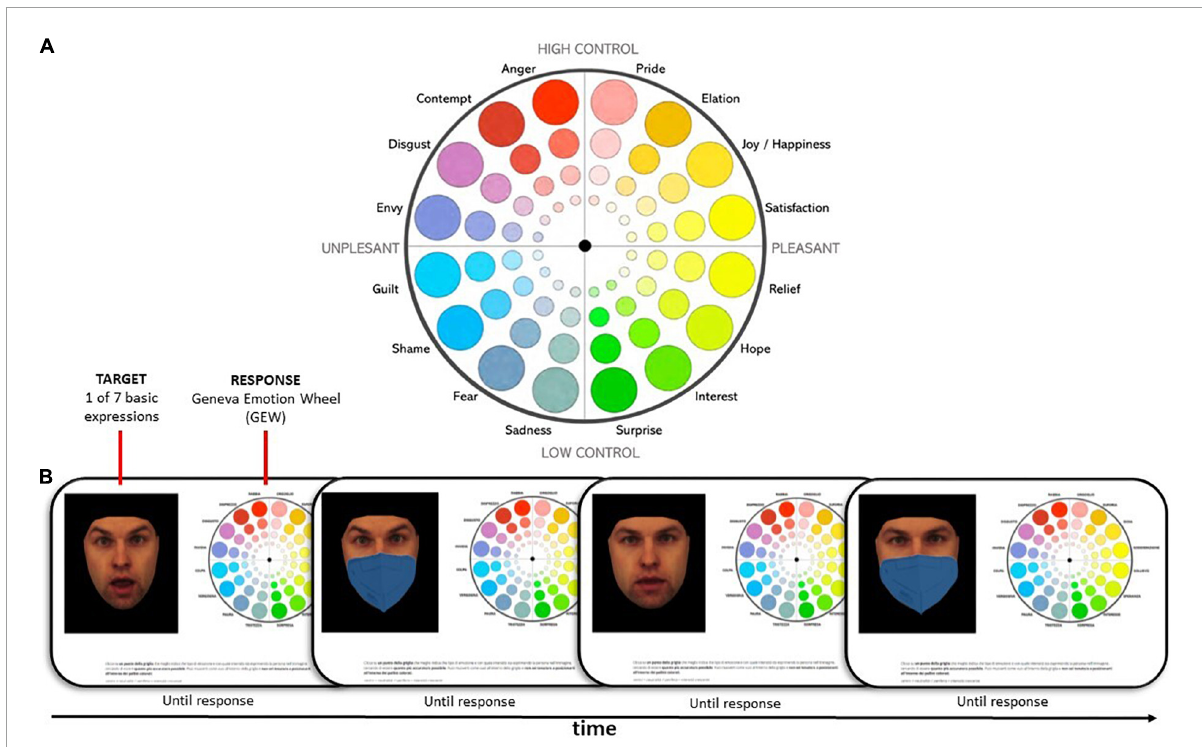
FIGURE1 Description of the experimental paradigm. (A) English version of the GEW 1.0. During the experiment, the labels were presented in Italian. (B) Trial example. Each trial consisted of a screen with the target face with or without the facial mask. The facial expression intensity could be full or subtle (except for neutral faces). Next to the face, the GEW was used to collect the response. There was no time limit, and the next trial start was self-paced. Images reproduced from KDEF (Lundqvist et al., 1998) with permission. Identity AM02 from the KDEF image set is